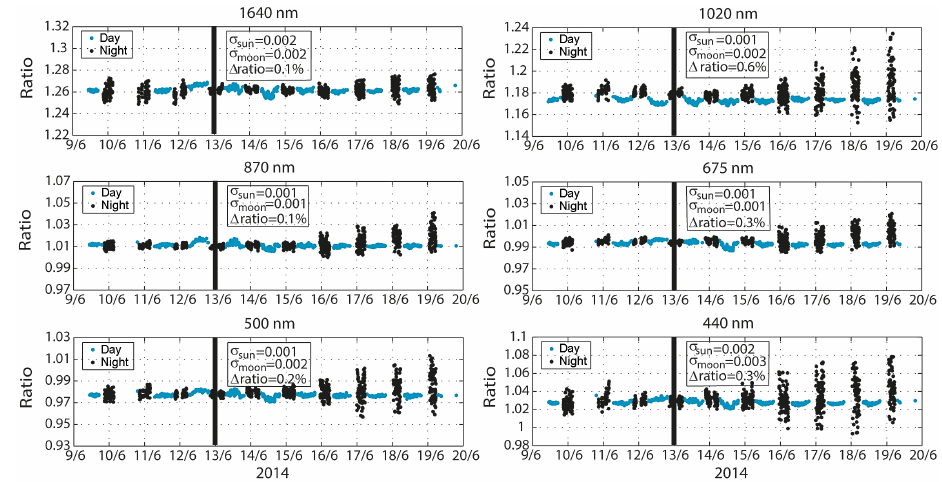
Figure 2. Ratio of simultaneous master/secondary signals at IZO performed on 11 consecutive days and 10 consecutive nights in June 2014. The vertical black line corresponds to the coincidence of full moon conditions. Standard deviations ( σ s) and ratio differences ( (cid:49) ratio) are depicted in each figure for ratios of sun midday and ± 1 night near full moon events.